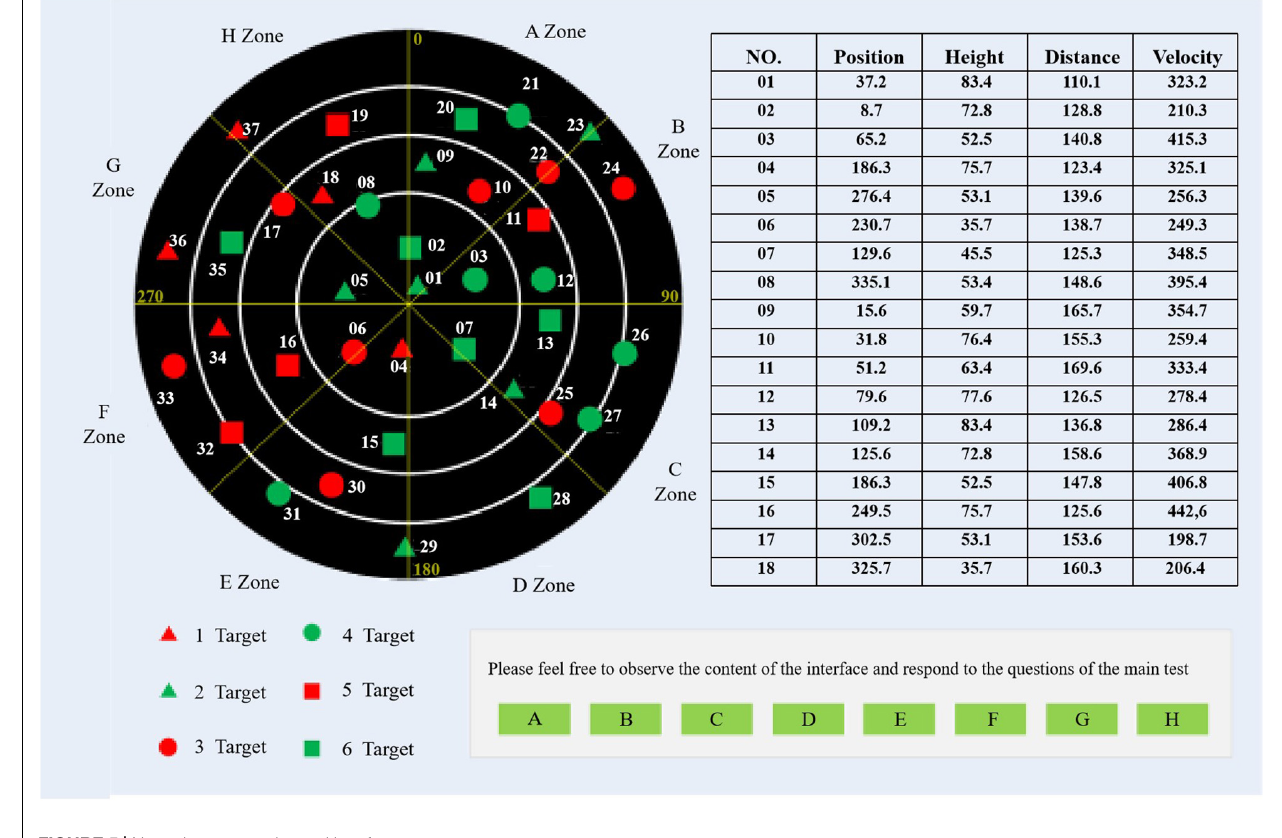
FIGURE 5 | Normal state experimental